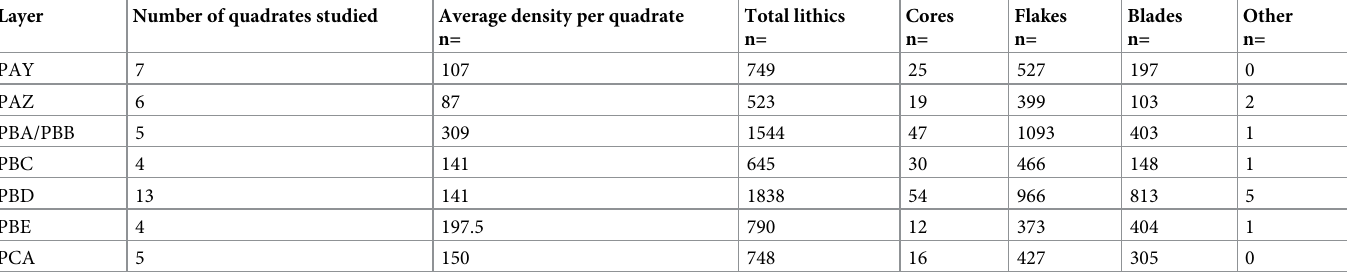
Table 1. General counts and composition of lithic material studied at KDS (exclusive of unretouched chunks and pebbles) and an indication of the density of lithics per layer. Layer Number of quadrates